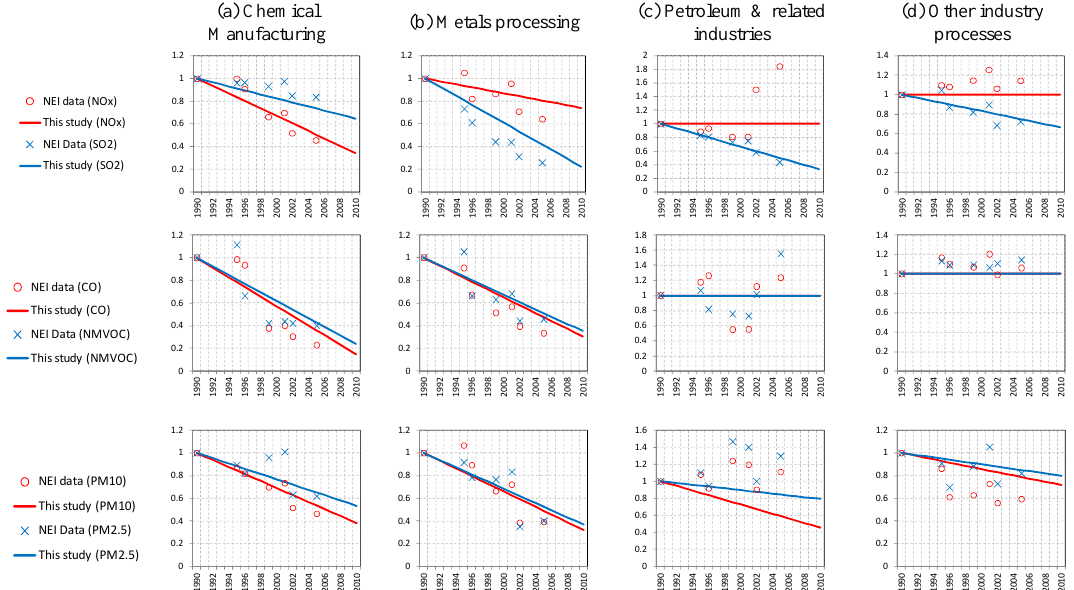
Fig. 6 Emission trends during 1990-2010 for industrial process sources (Year 1990=1, absolute values are provided in Table S2c) Fig. 6. Emission trends during 1990–2010 for industrial process sources (year 1990 = 1; absolute values are provided in Table